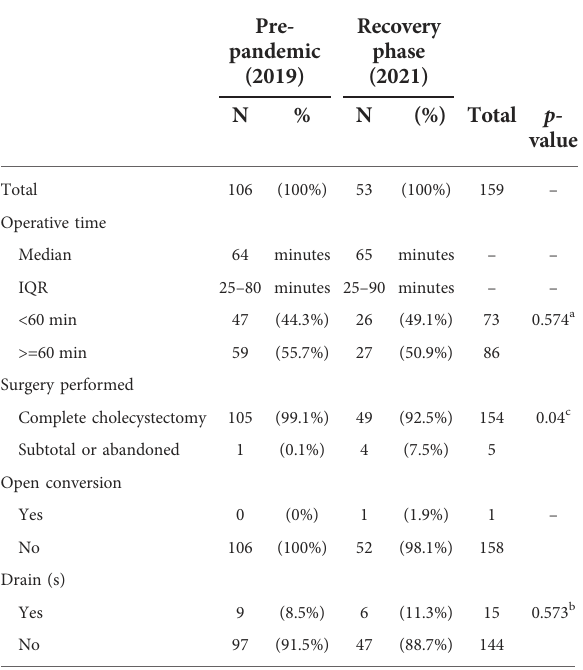
TABLE 3 Post-operative complications. TABLE 2 Intraoperative